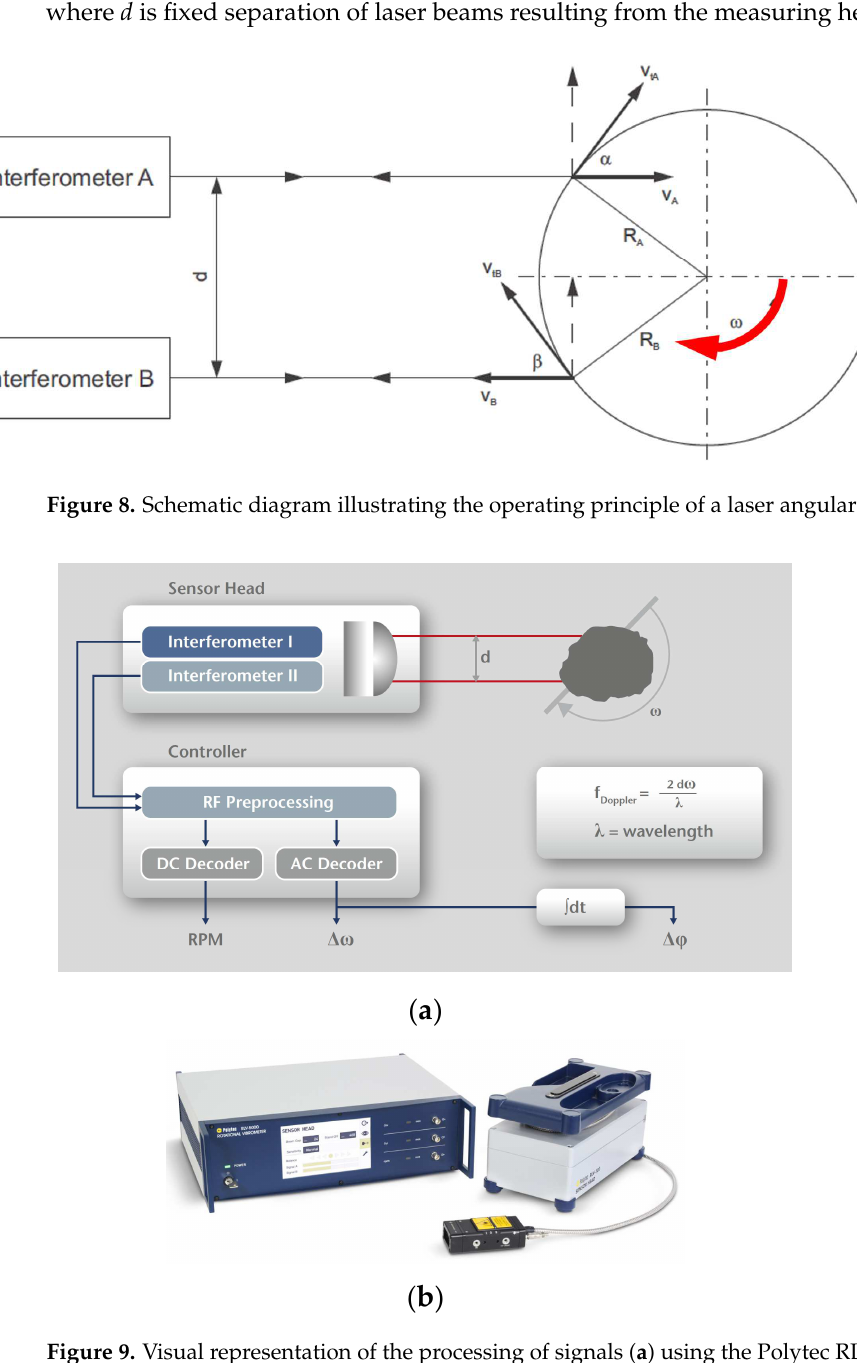
10 of 31 Figure 7. Arrangement of measurement points; designations: 1—driving motor, 4, 7—bearing support, 6—torsionally flexible metal clutch, 11—multistage reduction gear (subject to testing), 14— multistage mulitplying gear, 16—powder brake, 17—braking motor. As mentioned above, in order to provide the most comprehensive presentation of the relationships between the oscillatory processes observed in the subject of the tests as well as to demonstrate the effective operation of the clutch patented by two of the authors of this article, next to the conventional relays of vibration accelerations as well as the torque meters and the magnetic sensor used for angle measurement, as described in the previous section, also a concept of contactless laser measurement of the velocity of torsional vibra- tions, significantly less popular in measurements, was used under the studies. Figure 8 (drawn up with reference to [71]) visually represents the operating principle of a rotational laser vibrometer based on the Doppler effect, similarly to the laser vibrom- eters used to measure linear vibrations (one- and three-dimensional), the difference being